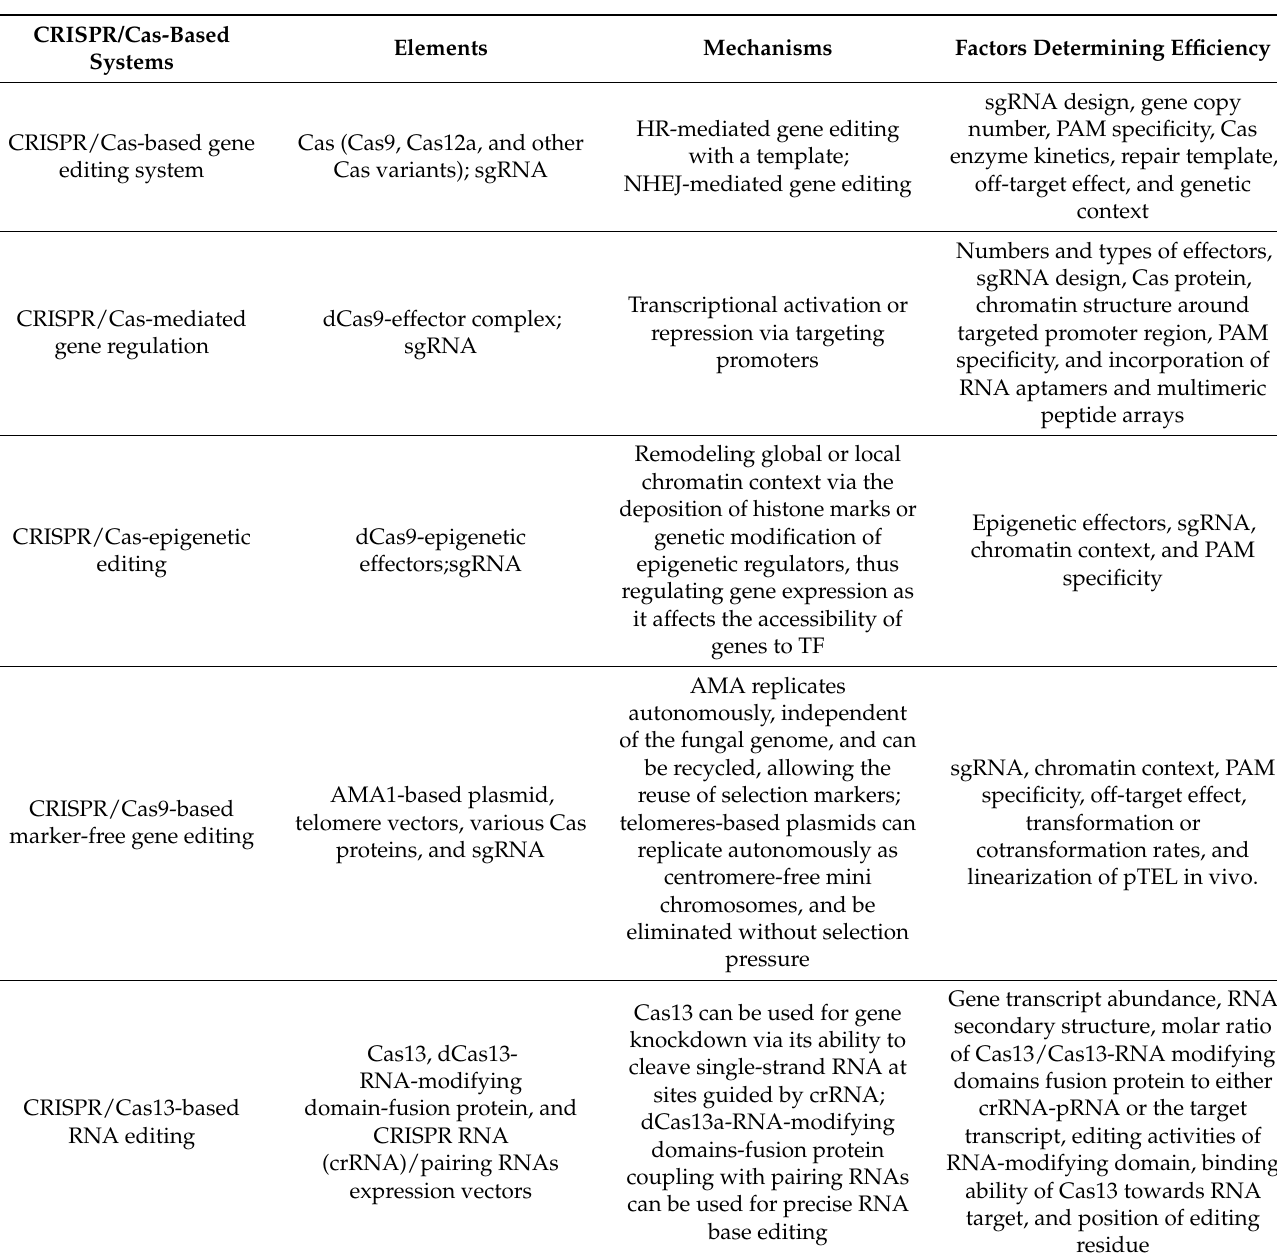
Table 1. A comparison of several major CRISPR/Cas-based systems for fungal genetic